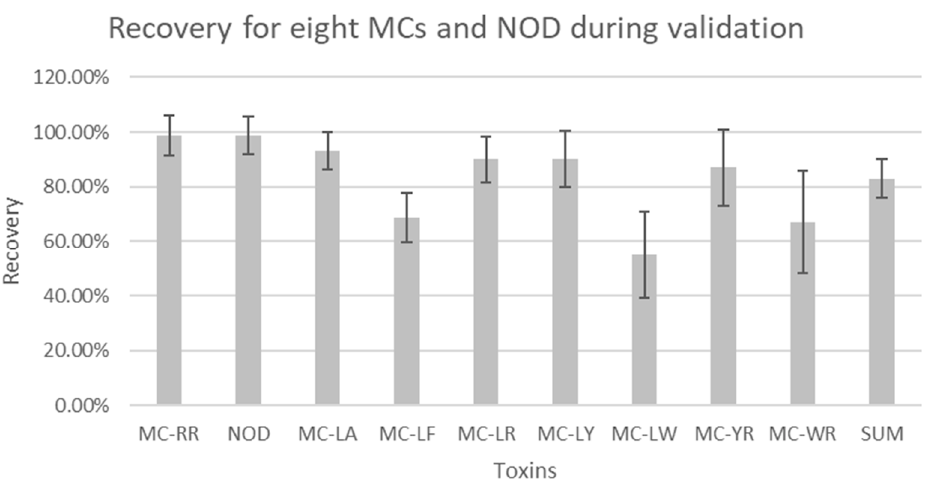
Figure 3. Recoveries for all eight microcystin congeners (MCs), nodularin (NOD) and their sum, are presented in the graph. The error bars represent the reproducibility.